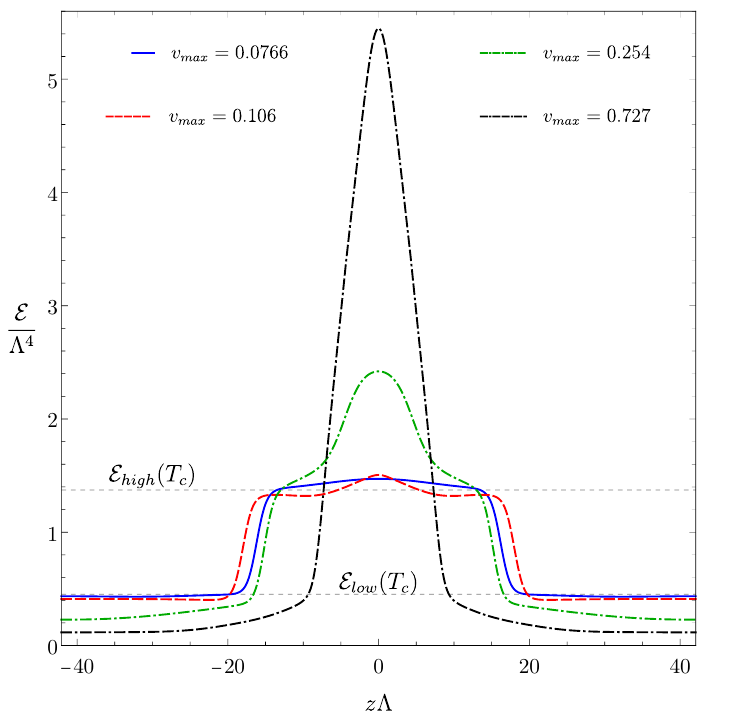
Figure 20 . Snapshots of the energy density at the times at which the maximum energy is reached for collisions with different v max .